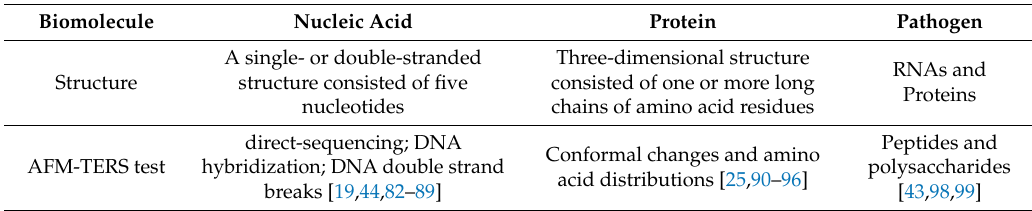
Figure 6. ( a ) AFM phase map of a whole spore acquired in tapping mode (scale bar = 500 nm, step-size = 20 nm): bright (dark) zones correspond to a positive (negative) phase-lag, namely to regions of higher (lower) stiffness; ( b ) Near-field (normalized) TERS spectra acquired in four selected positions over the spore coat, corresponding to the cross-marks in ( a ): in order to emphasize the relevant Raman features, background signal is identified by a fourth-order polynomial fitting routine and consequently subtracted; reprinted with permission from reference [99]; Copyright 2014 American Chemical Society. Table 3. The structure of the nucleic acid, protein and pathogen and their border of AFM-TERS had been detected by TERS